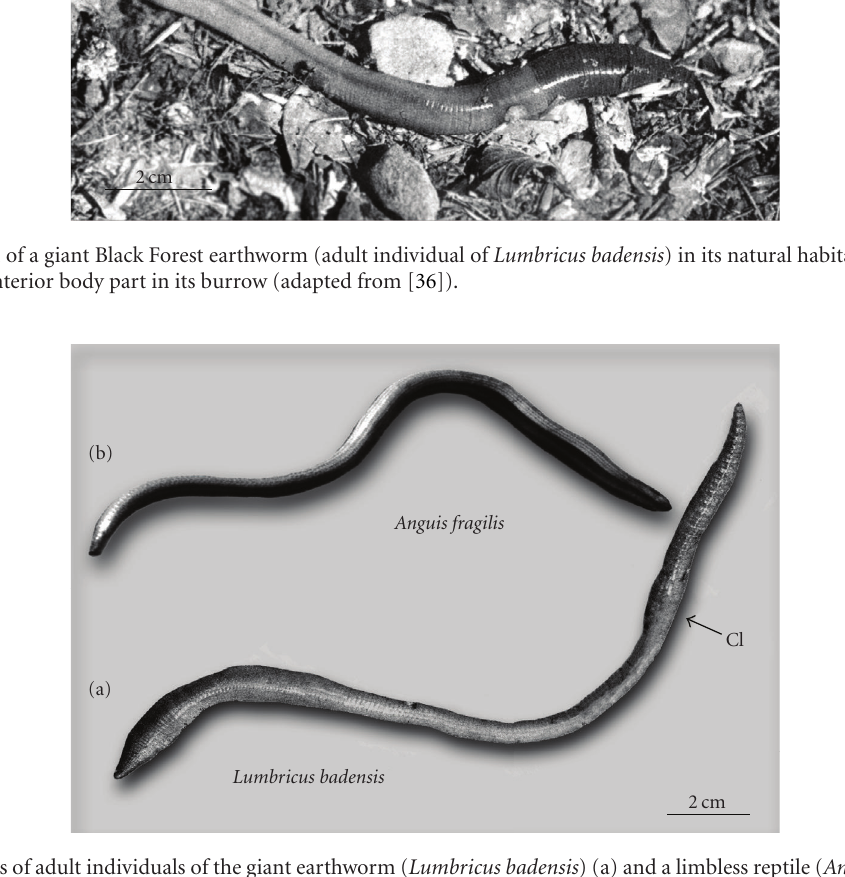
Figure 7: Photographs of adult individuals of the giant earthworm ( Lumbricus badensis ) (a) and a limbless reptile ( Anguis fragilis ), the ”slow worm” (b), collected in the same habitat in the Black Forest (Schauinsland, Southern Germany, ca. 1200 m above sea level). Note that the worm and the reptile are about the same size. The heads of both animals point to the right side. Cl =